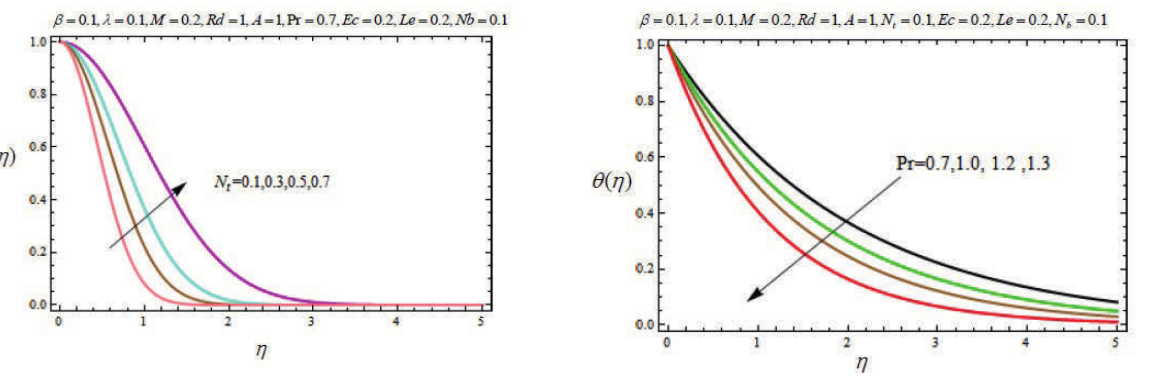
Fig. 11: Variation of temperature profile θ ( η ) with η for several val- ues of Prandtl number parameter Pr .